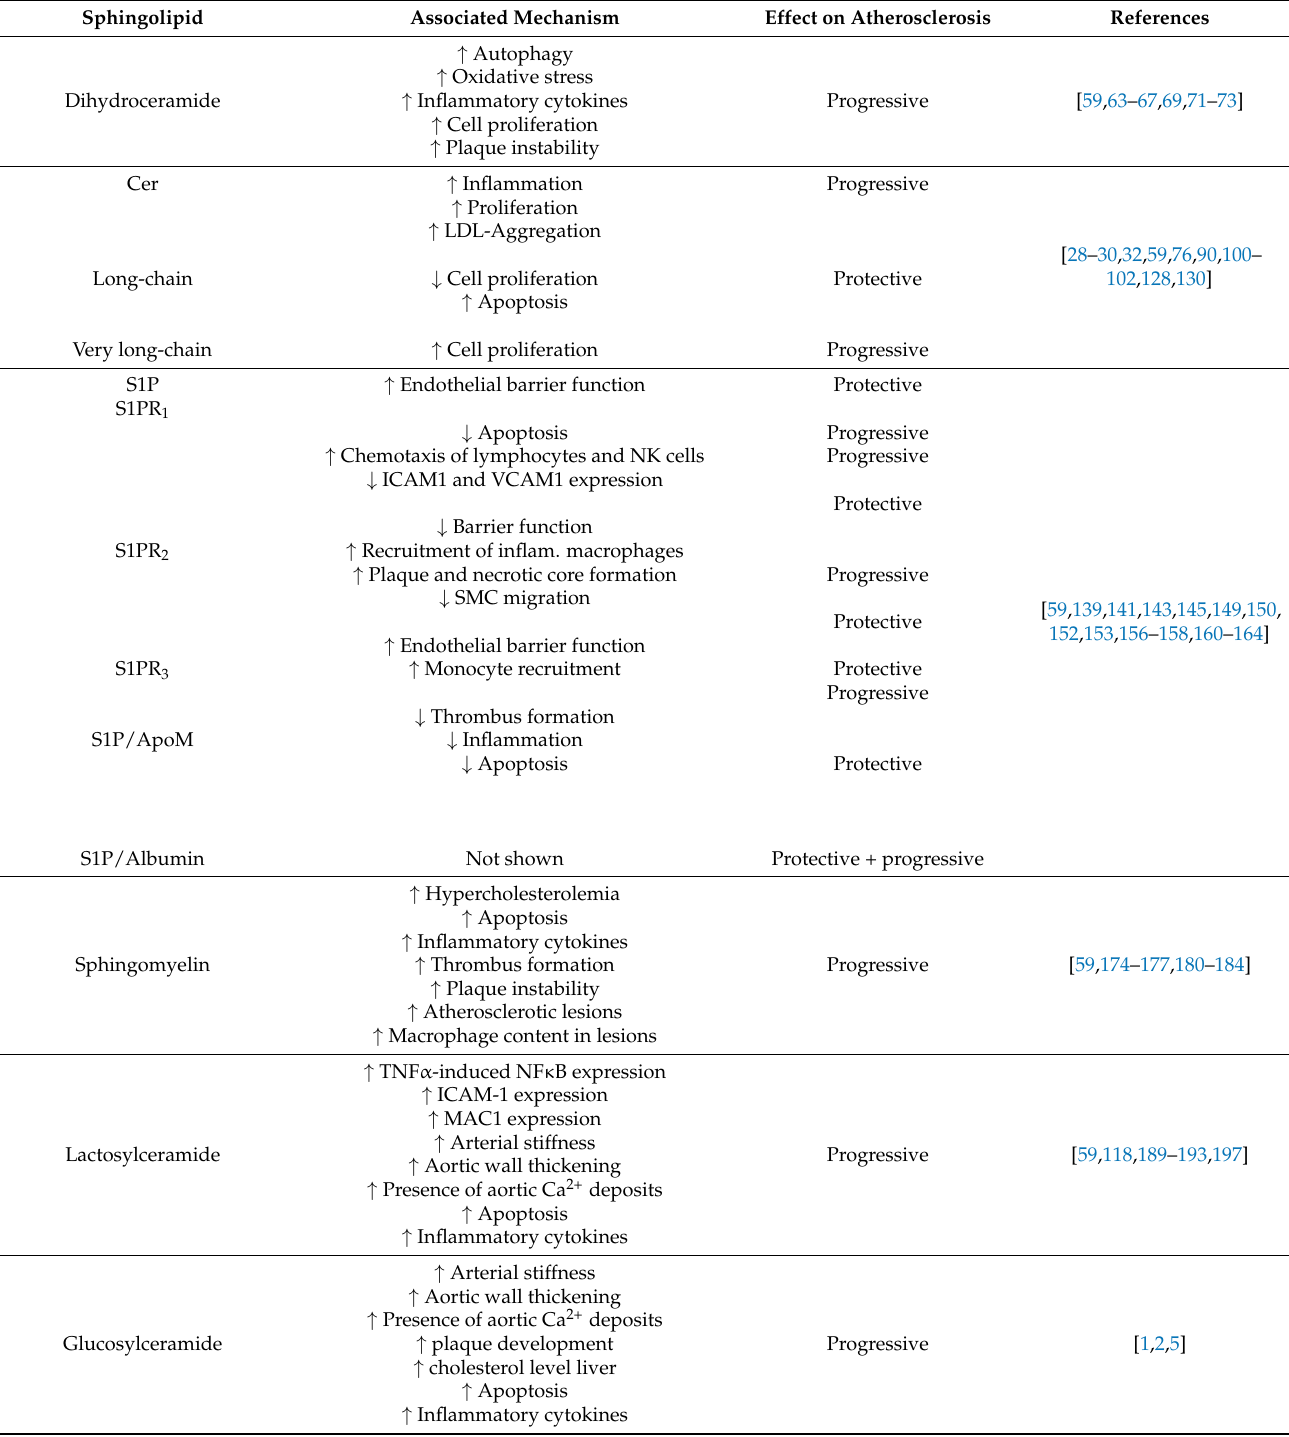
Table 1. Sphingolipids and their associated mechanism in atherogenesis. Sphingolipids exhibit molecular mechanisms, which are either categorized as atheroprotective or